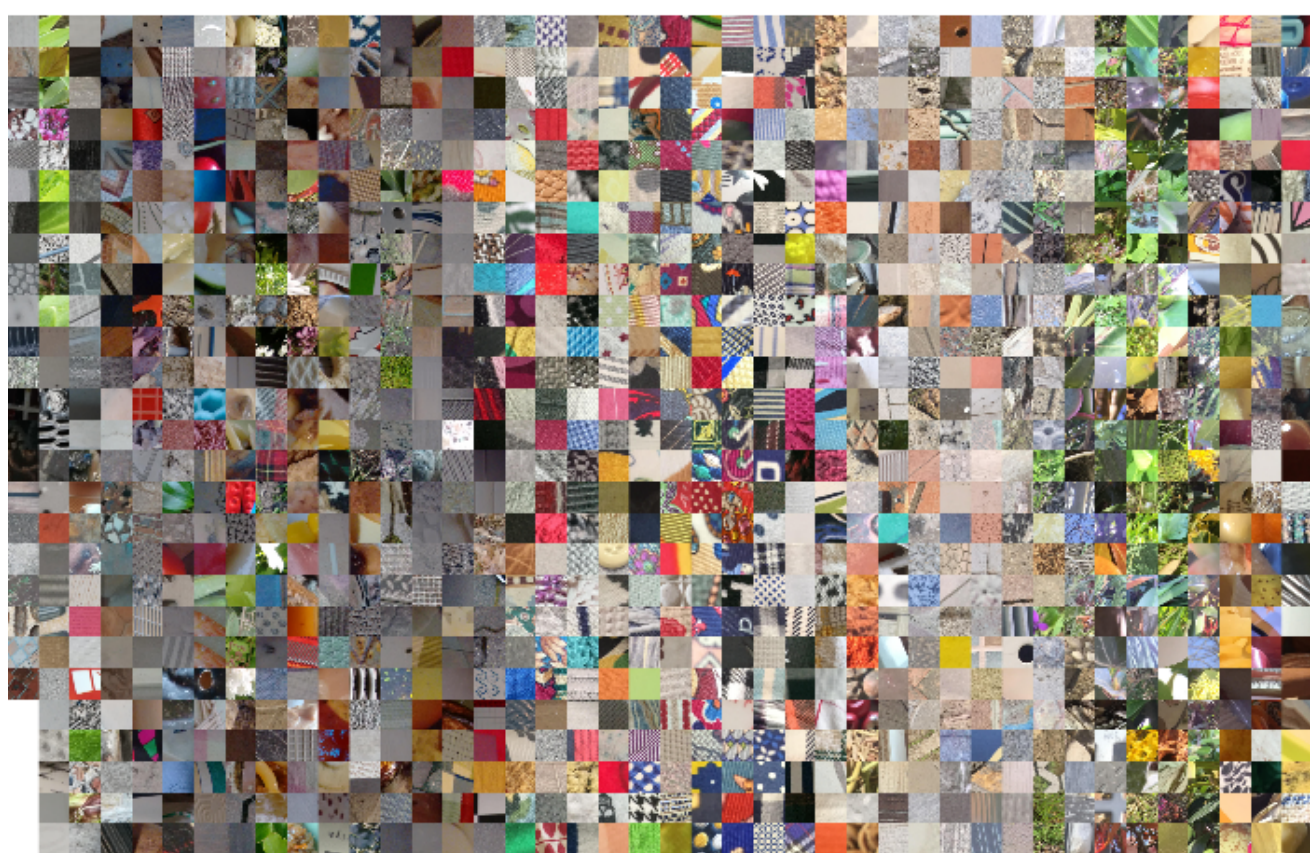
Figure 4. Overview of the database. For each class is included a patch taken from one of the